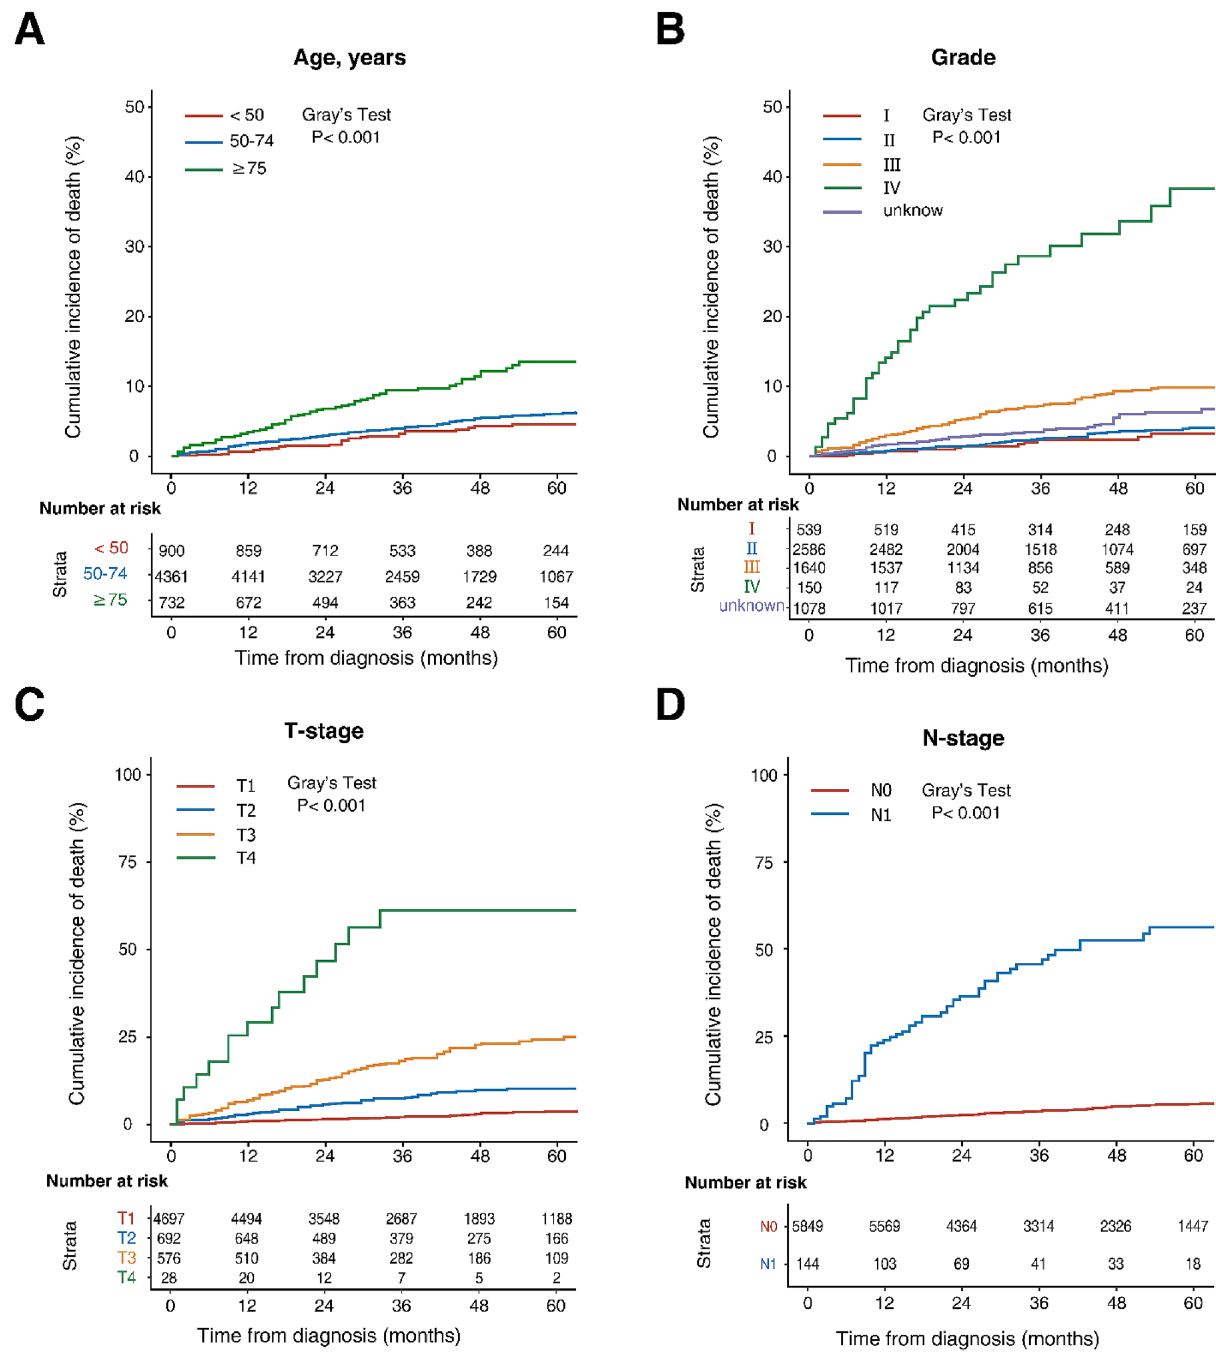
Figure 3. Cumulative incidences curves of CSM according to age ( A ), tumor grade ( B ), T stage ( C ) and N stage ( D ). The differences between groups were assessed by Gray’s test. CSM cancer-specific mortality. The figure was performed using R software (version 4.0.3, R Core Team 2020, https:// www.r- proje ct.